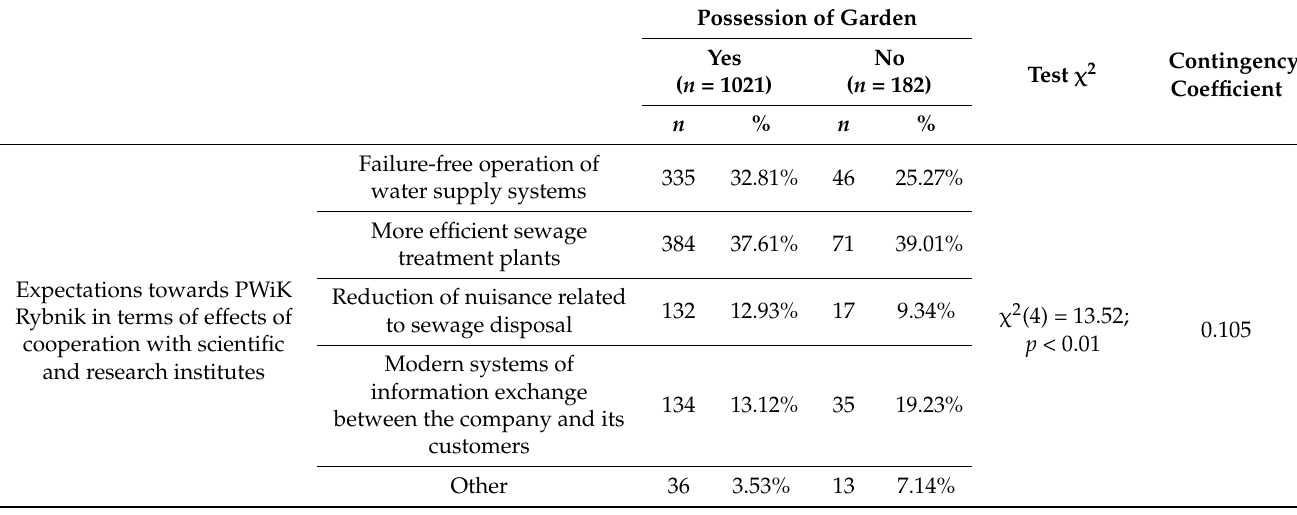
Table 6. Relationship between the respondents’ possession of a garden and their expectations towards PWiK Rybnik in terms of the effects of cooperation with scientific and research